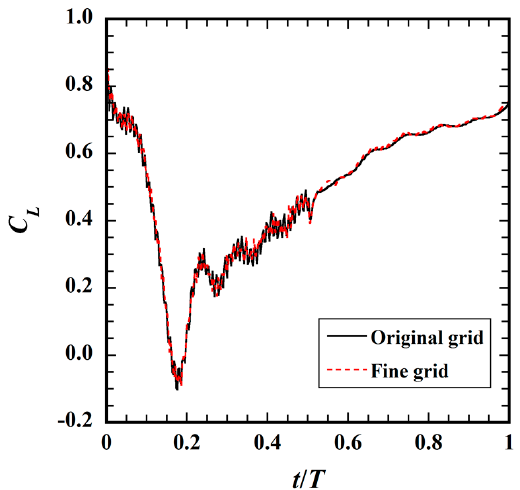
Figure 9. Predicted variation of lift coefficient for the control condition of t 0 / T = 0.0 and R = 50% with the original and finer grids.